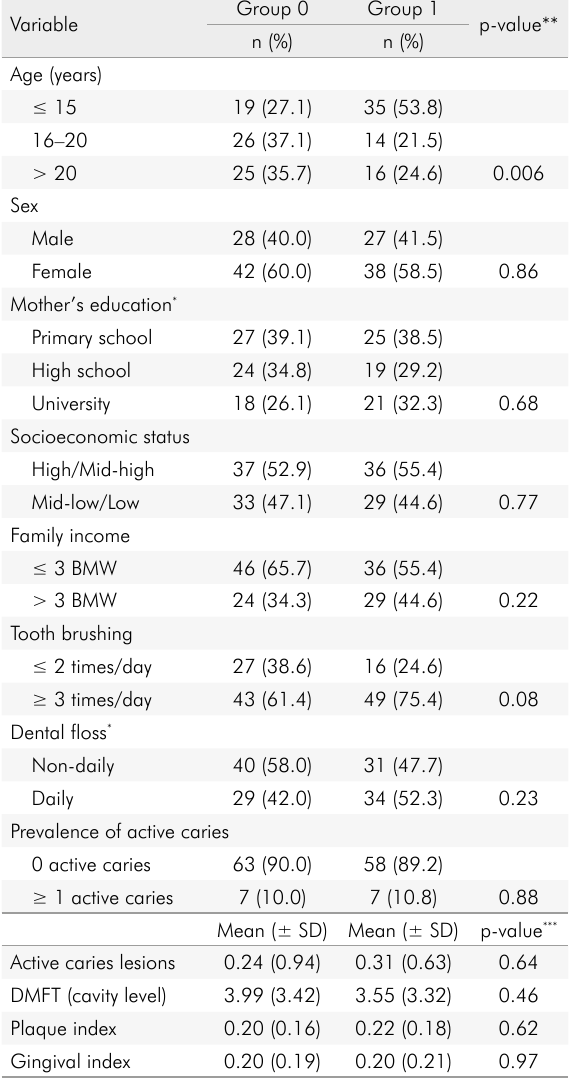
Table 1. Sample distribution according to baseline characteristics and